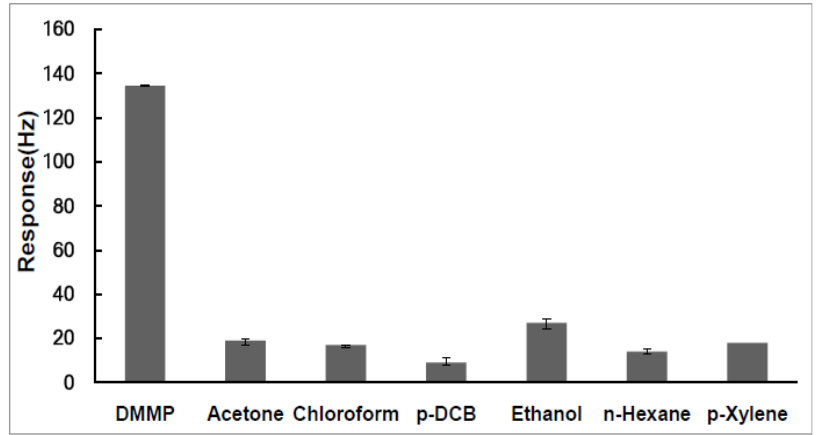
Figure 6. Comparison of the responses of the sensor to various organic vapors diluted to a predefined concentration of 0.7